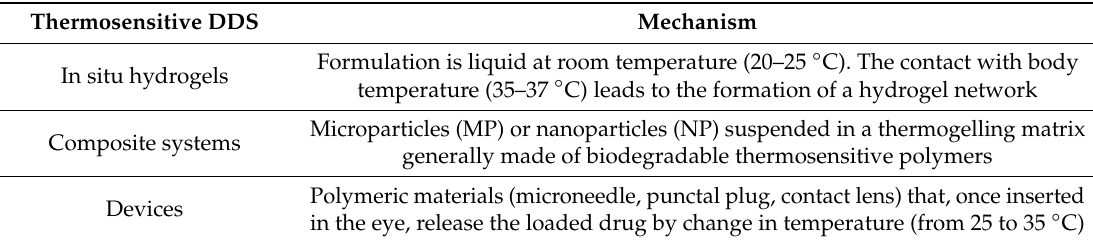
Table 1. Types of thermosensitive drug delivery systems (DDS) for ocular